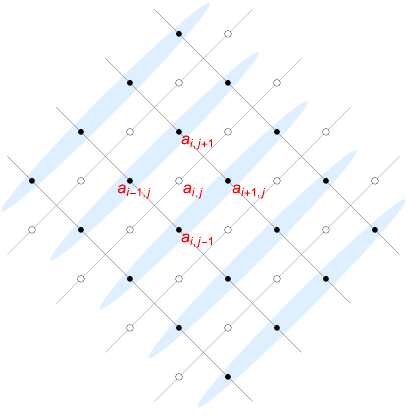
Figure 3 . Kink worldlines form a rectangular lattice on the string worldsheet. The field a ij lives on the edges (black or white dots depending on edge orientation). For κ = 1, the variables grouped together are equal (blue